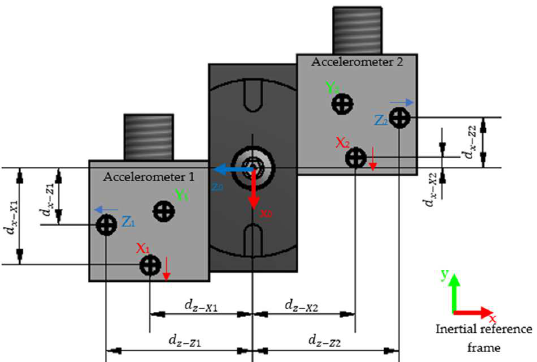
Figure 2. Nozzle and accelerometer assembly: accelerometer positions and their direction of meas- urement, where nozzle reference framework is (X0,Y0,Z0) and the inertial reference framework is (X,Y,Z). Note: The Y0, Y1, and Y2 directions can be found by the right-hand rule.